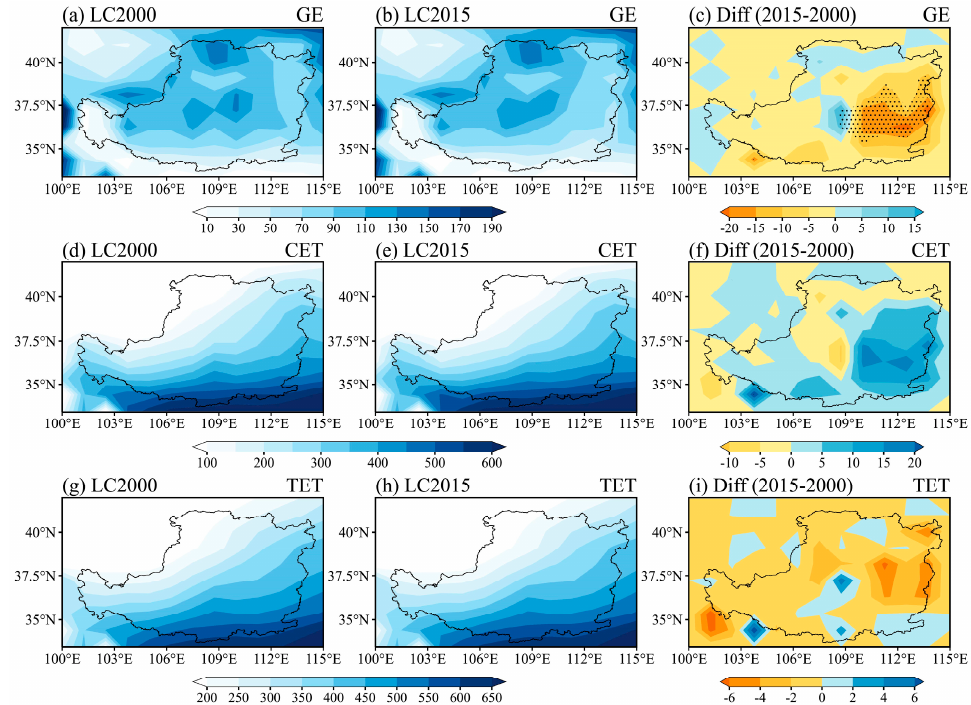
Figure 6. Spatial pattern of the simulated annual average ET (unit: mm) and differences (LC2015 minus LC2000) between LC2000 and LC2015 on the LP. The first column ( a , d , g ) and second column ( b , e , h ) show simulated ground evaporation, canopy ET and total ET under LC2000 and LC2015, respectively, and the third column ( c , f , i ) shows differences in ground evaporation, canopy ET and total ET between LC2015 and LC2000. Areas with significant differences ( p < 0.05) based on t -tests are stippled.